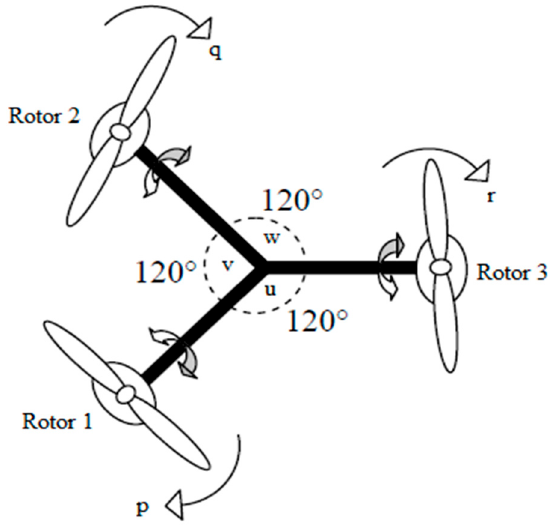
Figure 1. The structure of the tri-rotor aerial vehicle.